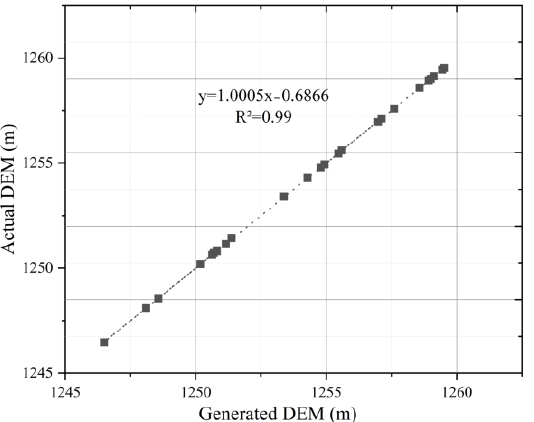
Figure 3. The fitting results of the generated DEM and the actual DEM. Slope and aspect are typical topographic factors. Hence, this study selected the two factors to investigate the relationship between topography and vegetation. The slope was calculated using the following Equation